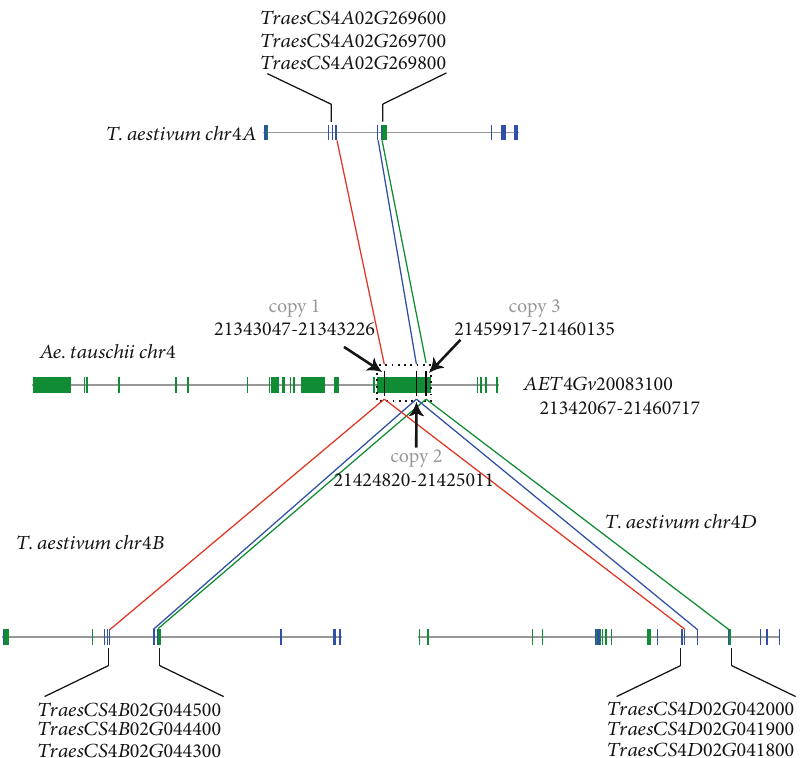
Figure 2: Collinear analysis of MAPEG genes in T. aestivum and Ae. tauschii . Orthologous MAPEG class genes are linked by lines of the corresponding color (red, blue, and green). Three high similarity regions of the AET4Gv20083100 gene are surrounded by a black dashed